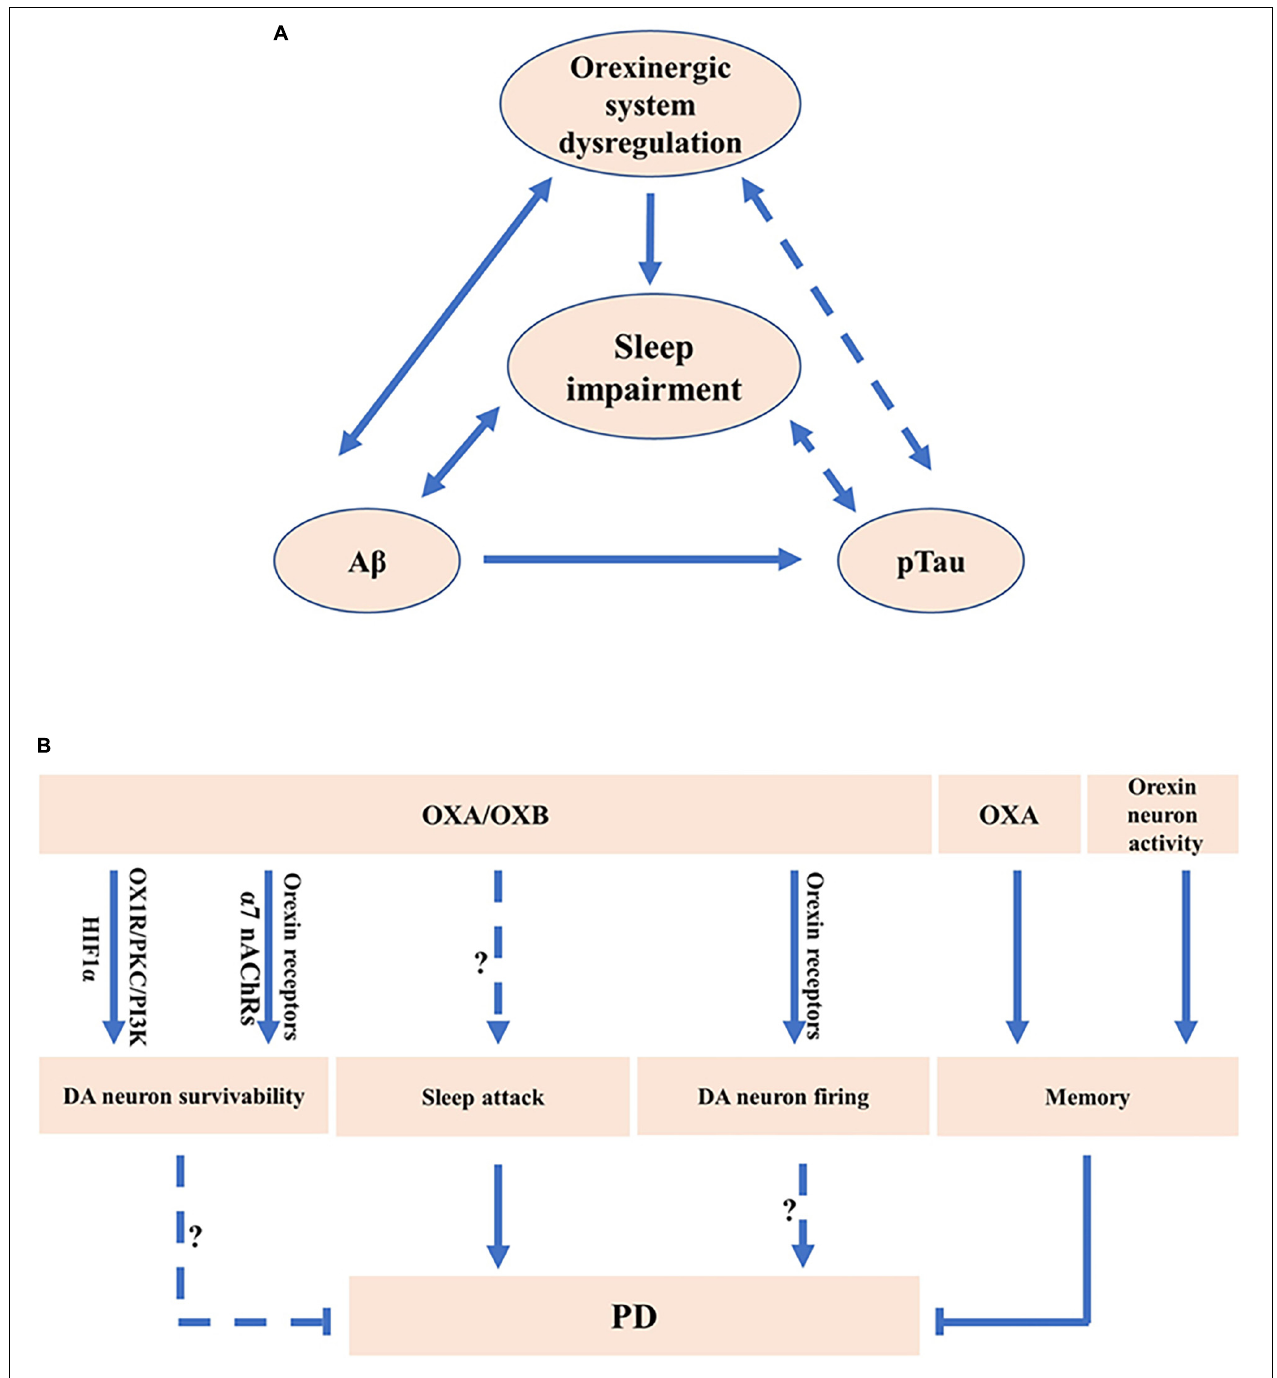
FIGURE 1 | The potential roles of orexinergic system in Alzheimer’s disease (AD) and Parkinson’s disease (PD). (A) The potential roles of orexinergic system in AD. Orexinergic system is involved in the regulation of sleep–wake states. Sleep disruption facilitated A β accumulation in AD. Orexin A (OXA) is associated with A β . Evidence also suggests a potential relationship between A β levels and sleep–wake states. Moreover, OXA in cerebrospinal fluid (CSF) was correlated with pTau. The levels of pTau were correlated with stage 1 of NREM sleep. More experiments are needed to clarify the correlation between pTau and orexinergic system-related sleep dysfunction. (B) The potential roles of orexinergic system in PD. OXA exerted the neuroprotective roles in PD cell model via regulating HIF-1 α or orexin 1 receptor (OX1R)/protein kinase C (PKC)/PI3-kinase (PI3K) signaling. Orexin 2 receptor (OX2R) and α 7 nAChRs were involved in the promotion of the survivability of DA neurons regulated by orexin B (OXB). OXA treatment or enhancement of orexin neurons activity markedly decreased the memory impairment in PD mice. OXA and OXB significantly increased the rate of spontaneous firing of dopaminergic (DA) neurons via OX1R and OX2R. Sleep attack has been observed in PD. Orexinergic system was involved in sleep disorders, indicating the potential roles of orexinergic system in regulating PD-related sleep disorders.